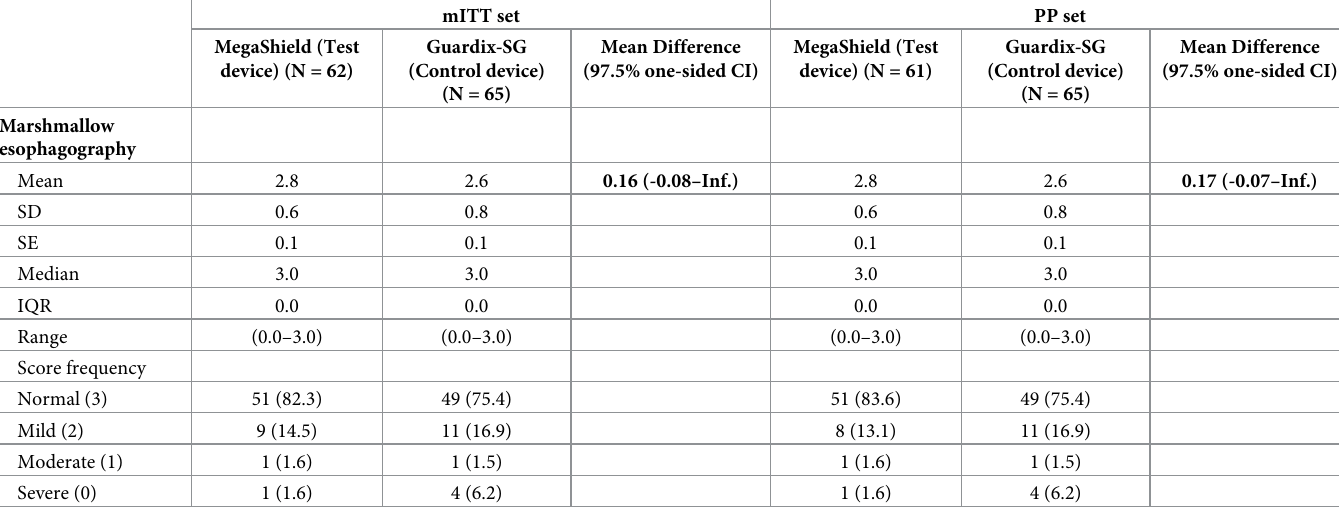
Table 4. Summary of marshmallow esophagography results at six weeks after thyroid gland surgery, visit 4 (day 42 ± 7). mITT set PP set MegaShield (Test device) (N =